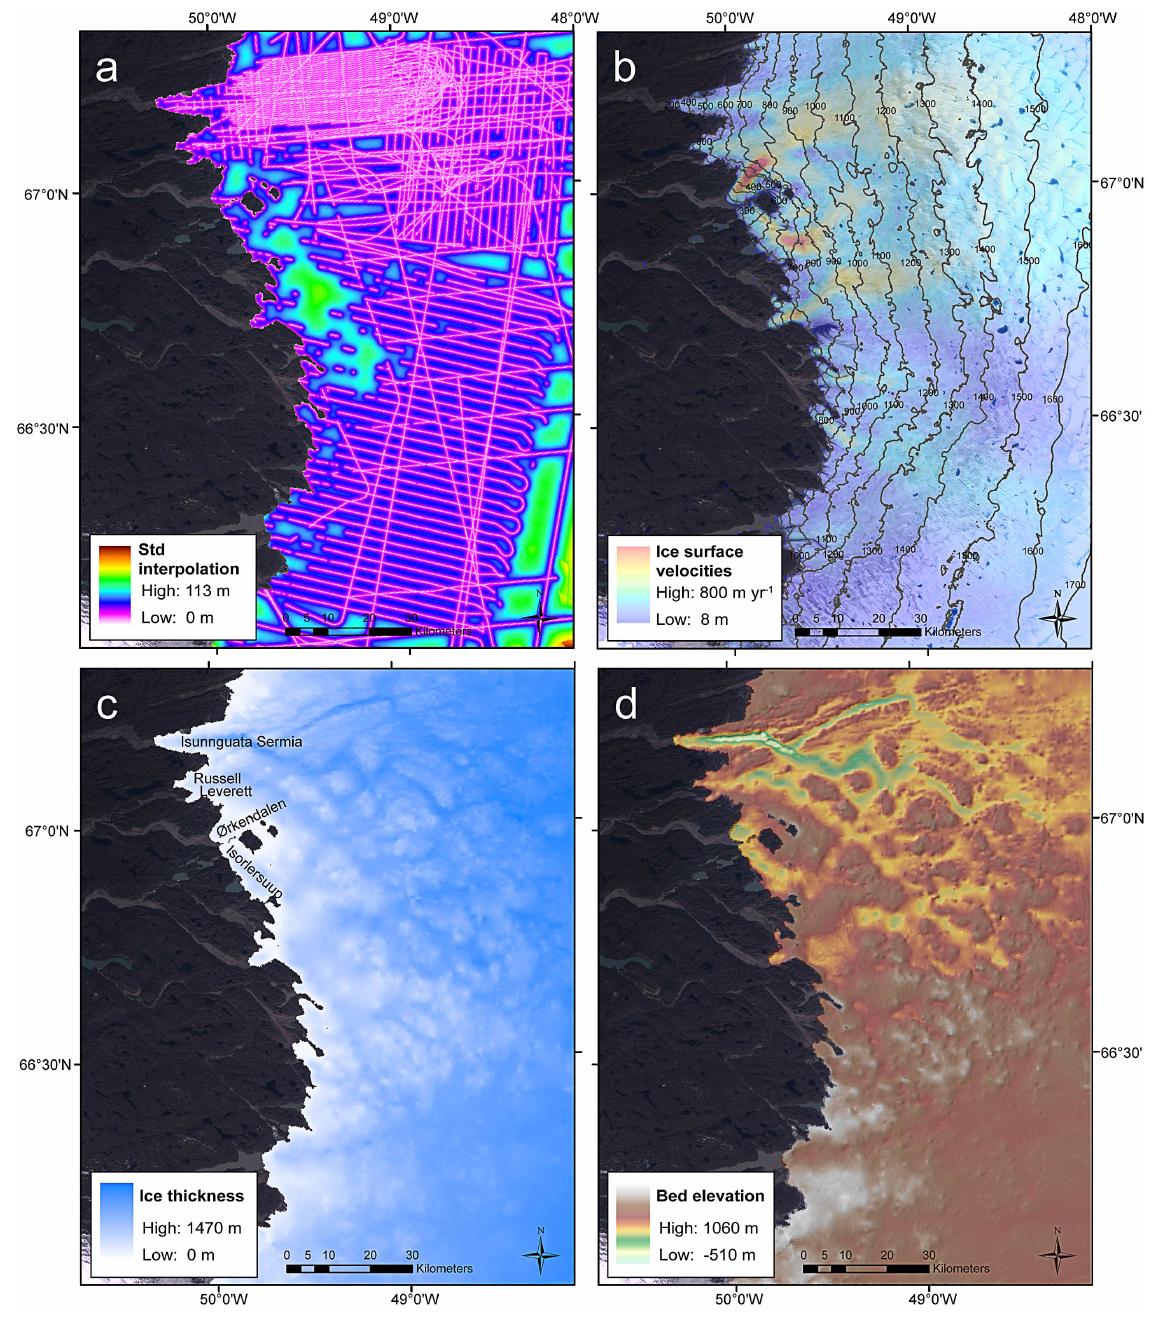
Figure 3. Maps of: (a) data quality showing the standard deviation of the interpolation of all three data sets; (b) surface elevation from the GIMP DEM (Howat et al., 2014) as height above the World Geodetic System (WGS)-1984 ellipsoid (contours) and ice surface velocities (colour scale) from Joughin et al. (2010); (c) interpolated ice thickness; and (d) interpolated bed elevation as height above the WGS-1984 ellipsoid. The background Landsat TM (Thematic Mapper) image was acquired on 9 July 2001.